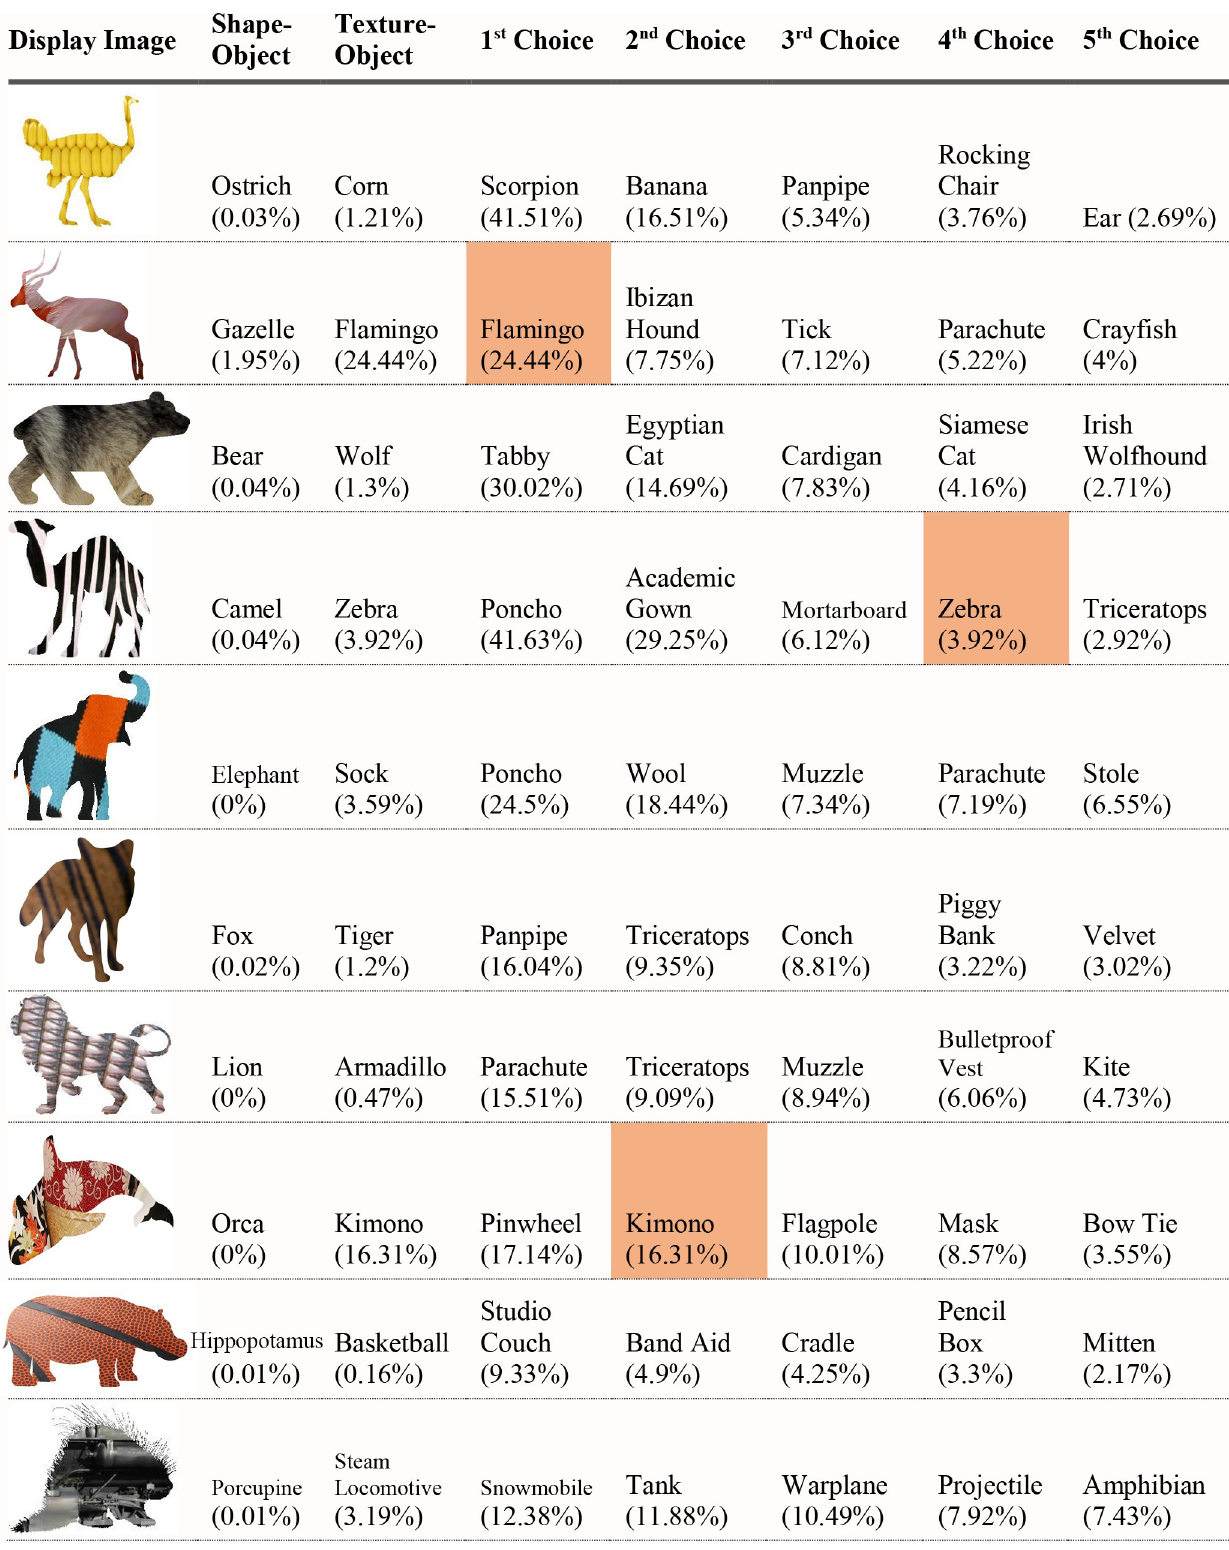
Fig 4. Network classifications for the stimuli presented in Experiment 1 Part 2.